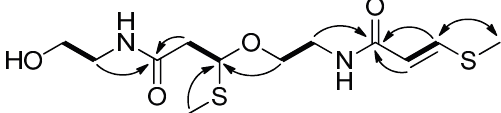
Figure 4. COSY (bold lines), key HMBC (arrows), and NOESY (left right arrow) correlations of 3